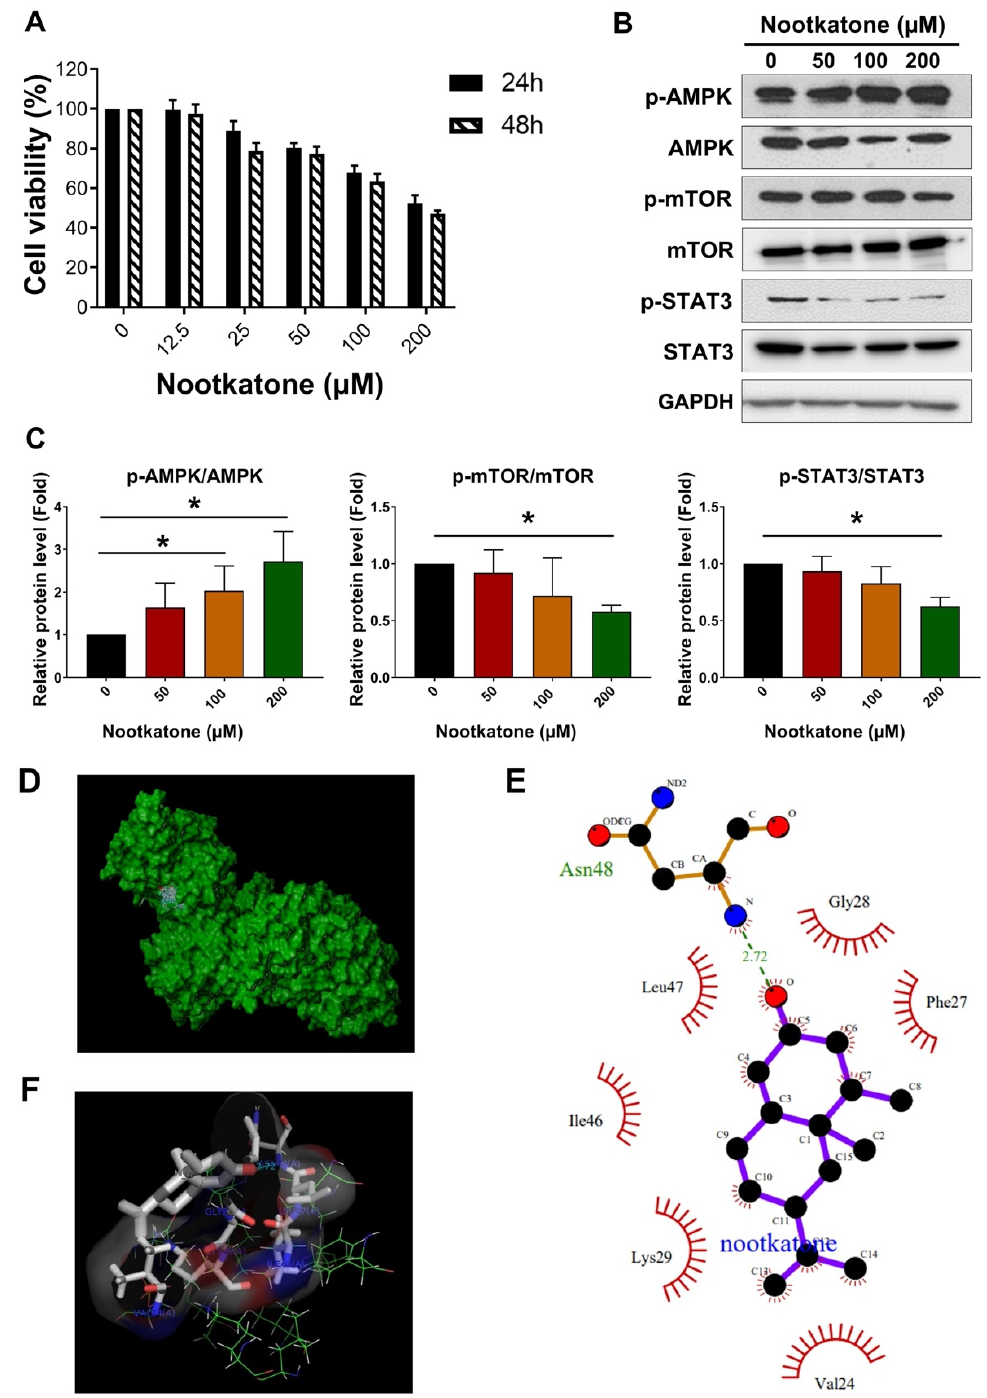
Figure 4. Nootkatone inhibited the proliferation of MCF-7SCs via AMPK activation. ( A ) The viability of MCF-7SCs was evaluated by MTT assay following nootkatone treatment for 24 h and 48 h. ( B ) Expression of AMPK, p-AMPK, mTOR, p-mTOR, STAT3, and p-STAT3 was detected by Western blotting following treatment with nootkatone for 48 h. GAPDH was used as a loading control. ( C ) Quantification of AMPK, p-AMPK, mTOR, p-mTOR, STAT3, and p-STAT3 expression normalized to GAPDH. ( D ) Image of the 30 nootkatone–AMPK complexes. ( E ) Interactions between nootkatone and AMPK analyzed using the LigPlot program. ( F ) Nootkatone–AMPK complex generated using the PyMol program. * p < 0.05 vs. control; statistical values represent data from three biologically independent experiments.